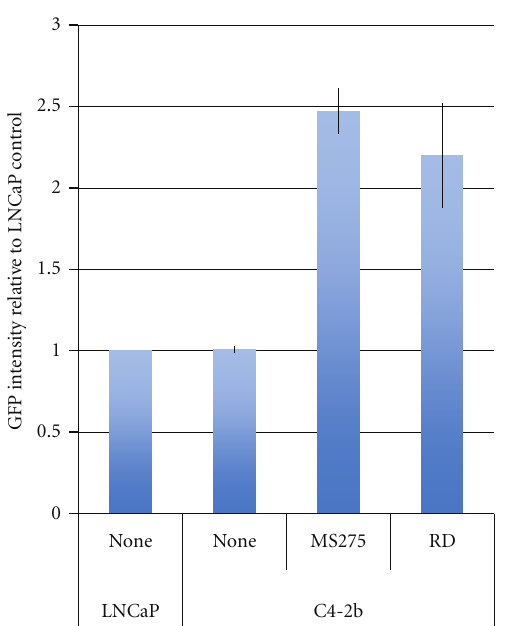
Figure 8: The e ff ect of HDACi on GFP intensity in C4-2b cells. Cells were plated overnight and exposed to 10MOI AdGFP in the presence or absence of 100 ng/mL Romidepsin or 10 µ M MS-275. The geometric mean fluorescence intensity within GFP-positive cells is expressed as a fold change relative to LNCaP cells. Data shown are the Mean ± SD from three